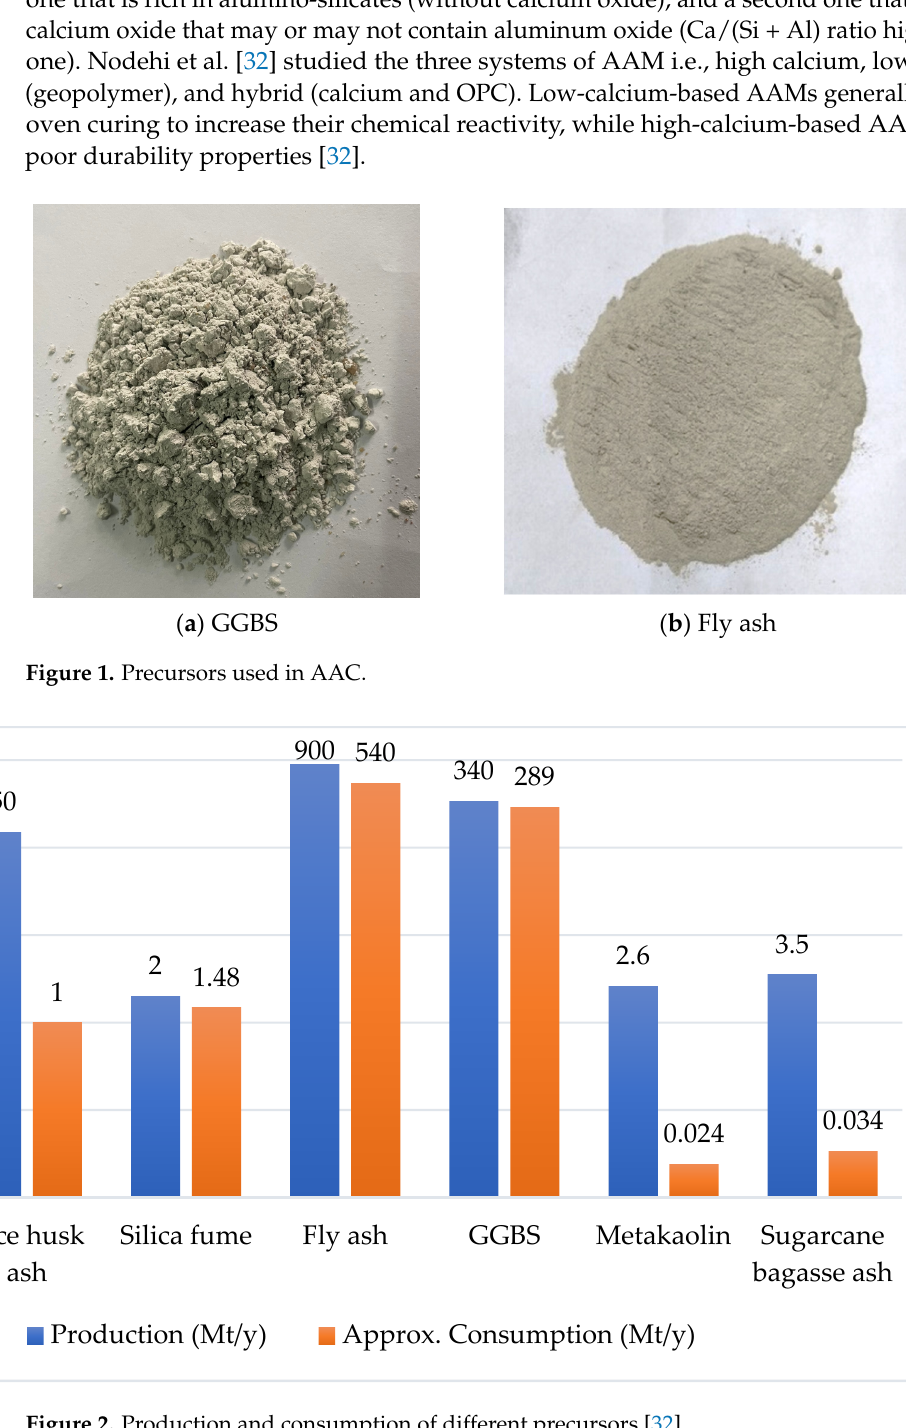
Figure 2. Production and consumption of different precursors [32].